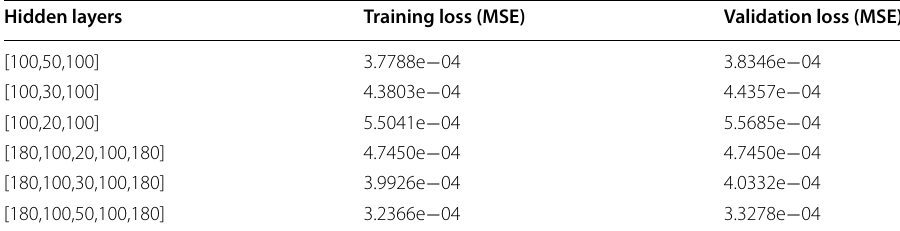
Table 7 Experimental results for different hidden layers configurations Hidden layers